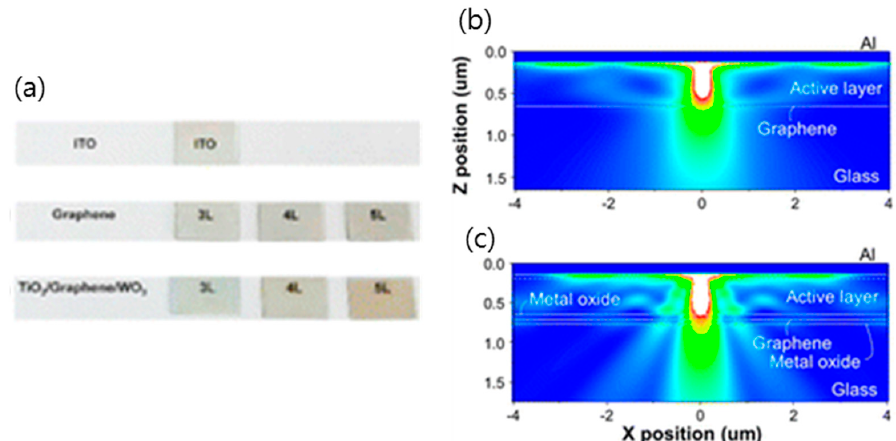
Figure 11. ( a ) Photographs of ITO, graphene, TiO 2 /graphene/WO 3 of 3–5 graphene layers. The Finite-Difference Time-Domain (FDTD) simulation. Calculated Poynting vector magnitude of OLEDs ( λ = 520 nm) on ( b ) 3 layers graphene (G) and ( c ) TiO 2 /3 layers graphene/WO 3 electrodes by FDTD method. Reproduced with the permission of Reference [69]. Copyright 2016, American Chemical